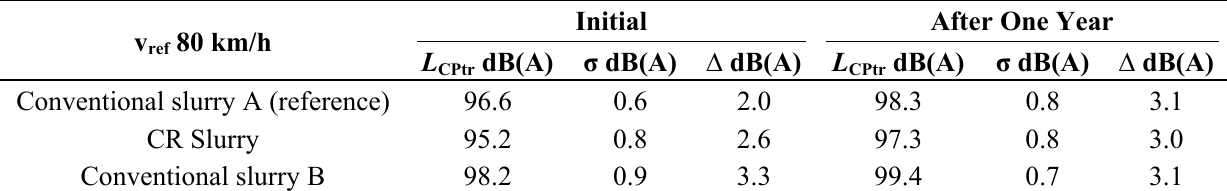
Table 2. Characteristic close proximity level ( L range of variation ( ∆ ) associated to the studied